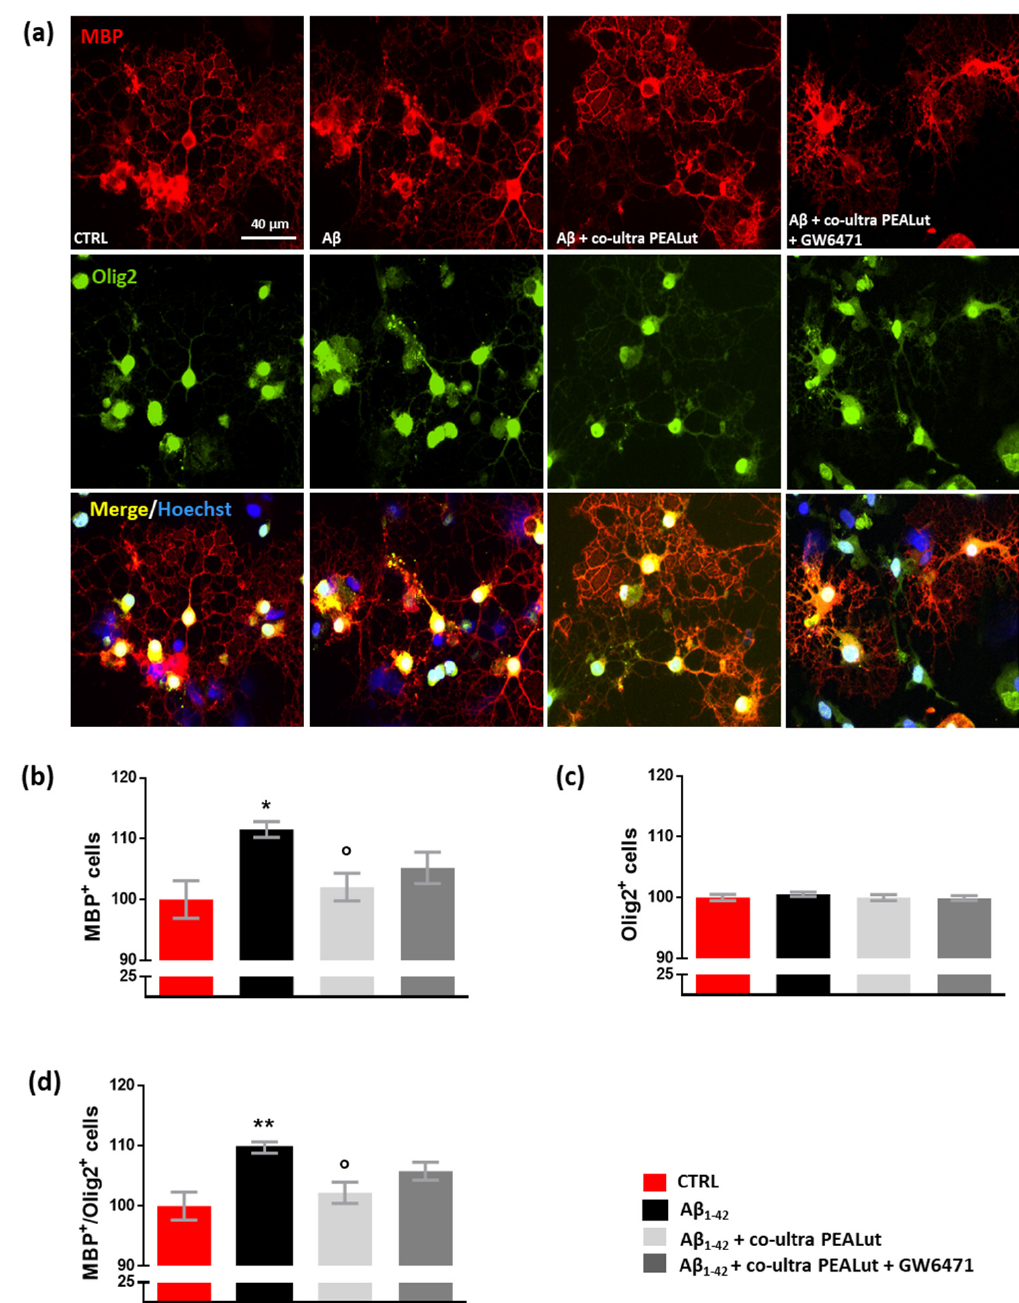
Figure 4. Co-ultra PEALut dampens the altered MBP + /Olig2 + ratio caused by A β 1–42 . ( a ) Representative photomicrographs of MBP (red) and Olig2 (green) staining of primary oligodendrocytes obtained using a 20 × objective mounted on a fluorescent microscope. Cell nuclei were stained with Hoechst (blue). Scale bar is 40 µ m. ( b ) MBP + cell count. ( c ) Olig2 + cell count. ( d ) The ratio of MBP + to Olig2 + cell counts. Treatments with human fibrillary A β 1–42 1 µ m in the presence or absence of co-ultra PEALut 3 µ m, GW6471 3 µ m (or respective vehicles) were added to the astrocytic culture medium. Semi-permeable inserts containing the primary oligodendrocytes were collected 48 h later and processed by immunofluorescence. Data are plotted as mean ± SEM and expressed as percentage variations vs. the vehicle-treated group (CTRL). * p < 0.05; ** p < 0.01 vs. CTRL; ◦ p < 0.05 vs. A β (SNK